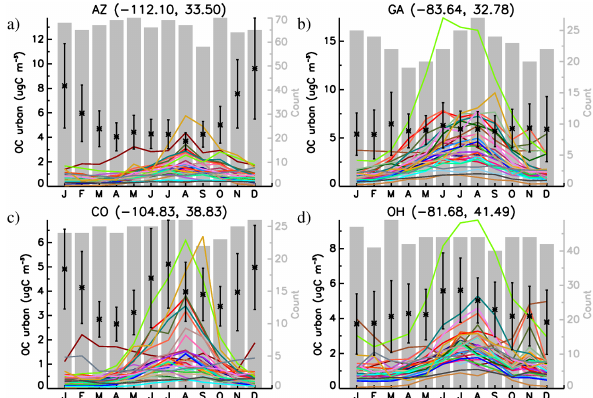
Figure 16. Typical seasonal distribution of OC measurements and comparison with model results for urban stations. Stars show the monthly mean of all measurements from all years that data are available, error bars present the standard deviation of the averaged measurements per month, and lines show model results, colored as in the previous figures. The grey bars show the number of mea- surements per month. The stations used are Arizona ( a ; 112.1 ◦ W, 33.5 ◦ N, years 2000–2007); Georgia ( b ; 83.64 ◦ W, 32.78 ◦ N,